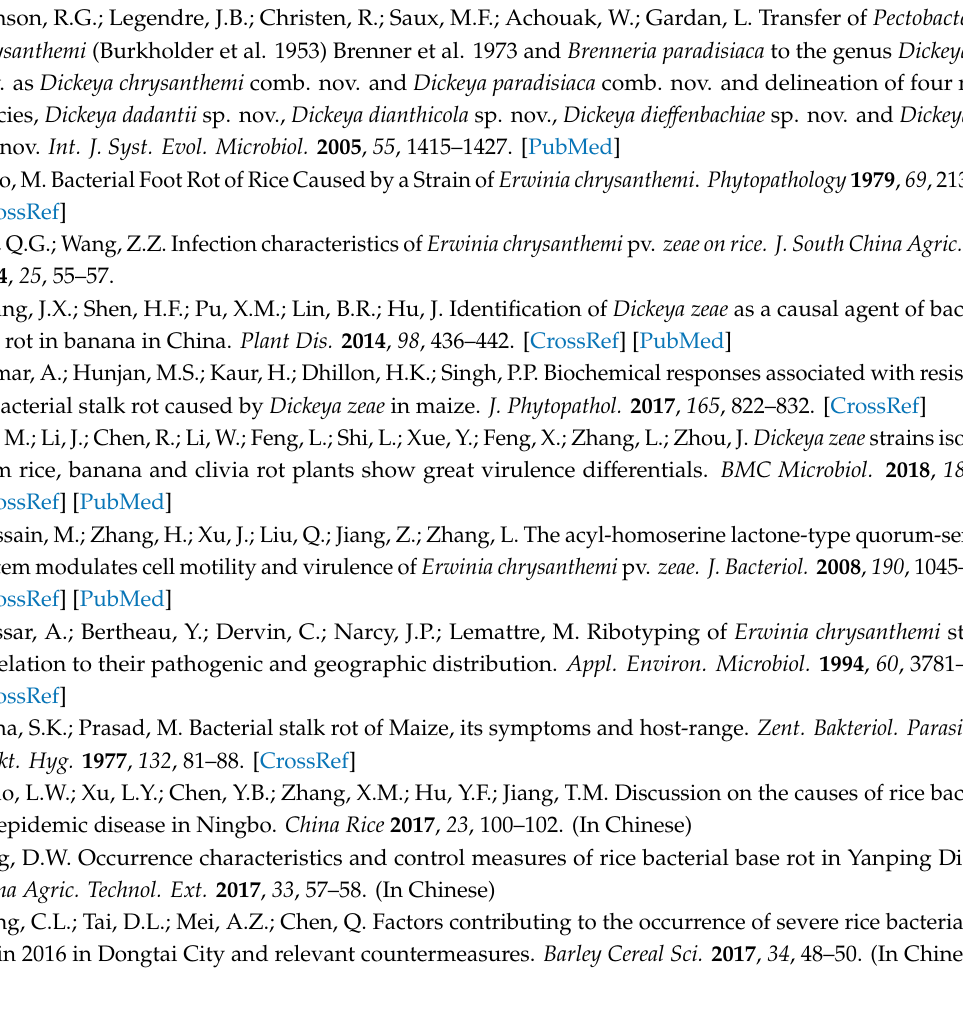
Figure S1: Inhibitory activities of strains SC3, SC11 and 3-10 against the growth of strains SC3 and SC11 in spot-on-lawn assay, Figure S2: Inhibitory activities of strains SC3, SC11 and 3-10 against the sexual mating of Sporisorium scitamineum, Figure S3: Phylogenetic tree based on the concatenated nucleotide sequences of the 16S rRNA gene of bacterial strains used in this